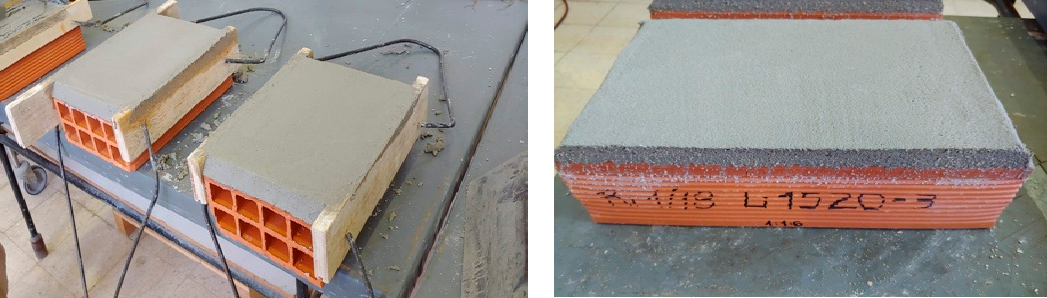
Figure 2. Mortar application on a brick.